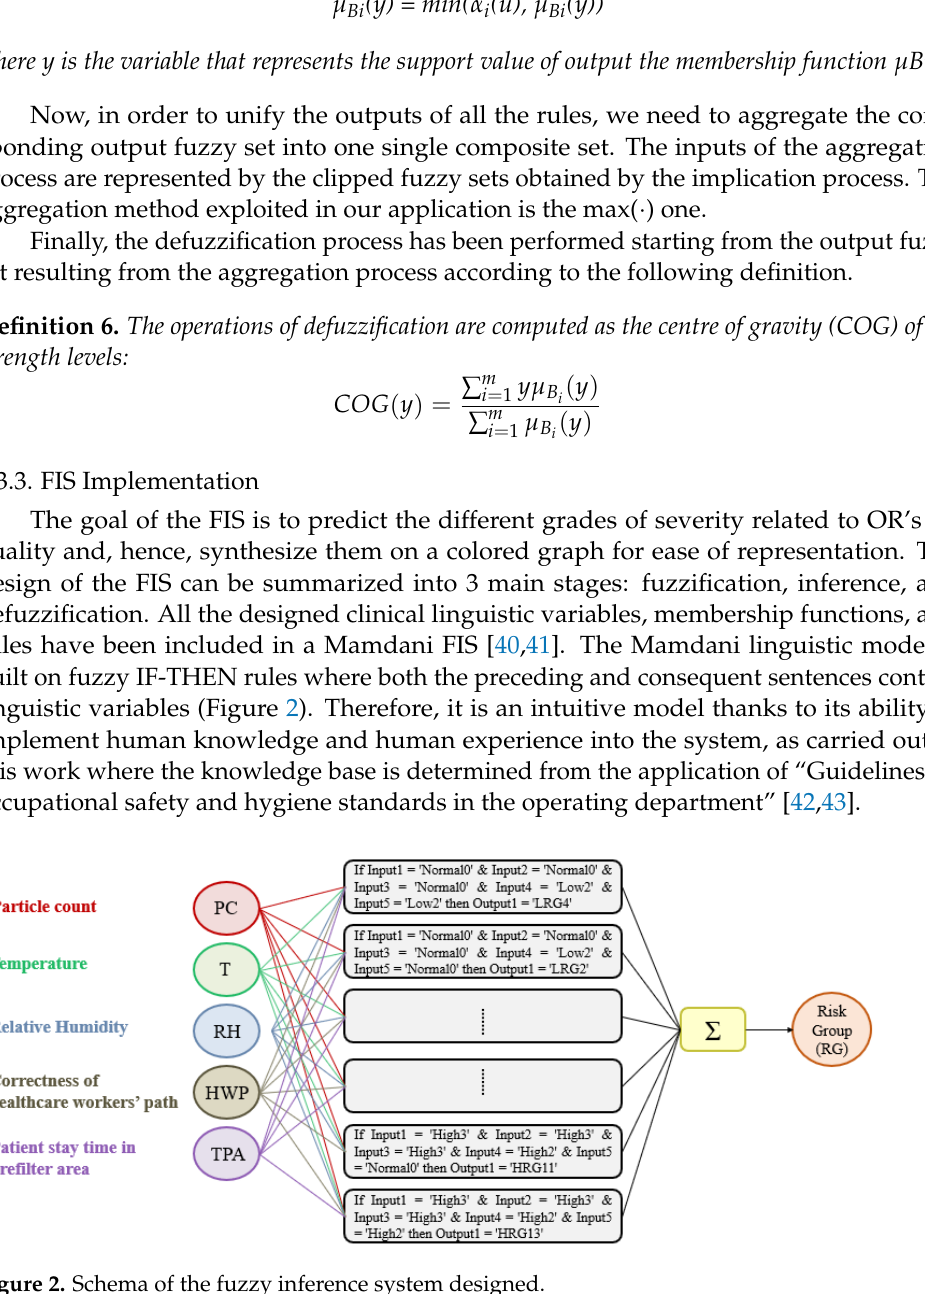
Figure 2. Schema of the fuzzy inference system designed .